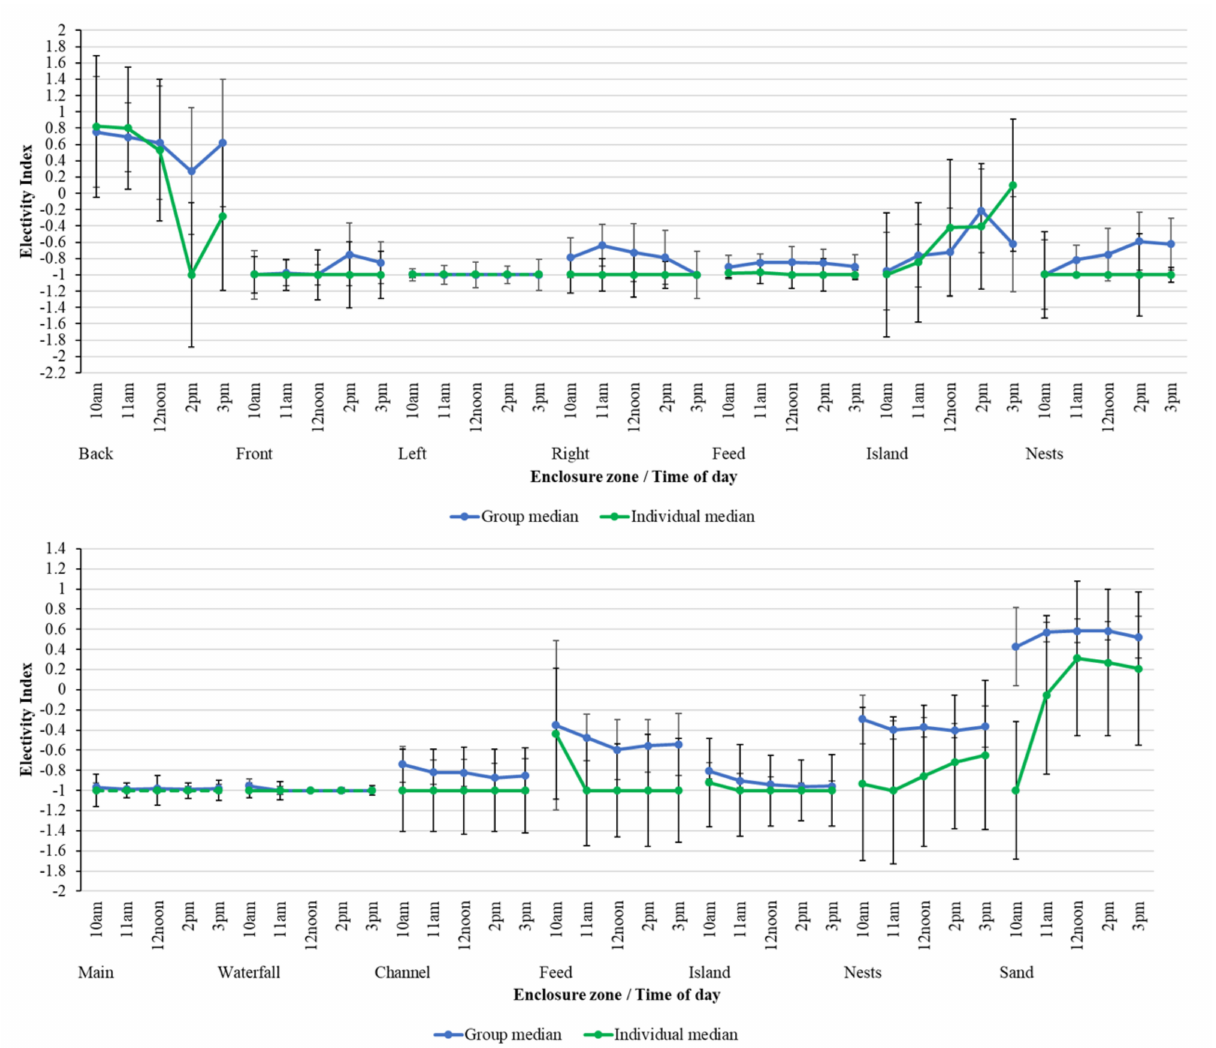
Figure 6. Comparing group-level median EI against individual median EI for PZ ( top ) and BZ ( bottom ) over time of day for each zone within the flamingo enclosures. Median EI values are from − 1 to +1 and these are plotted with standard deviations, calculated from all data points for each time period in each zone, to show variation around each average